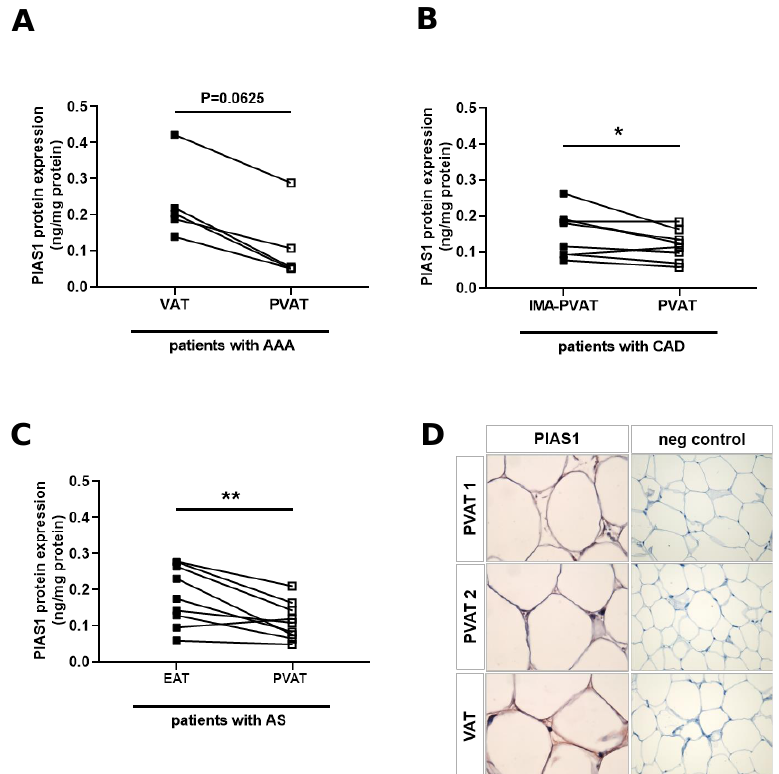
Figure 6. Expression of PIAS1 in human perivascular adipose tissue. Quantitative analysis of PIAS1 protein levels in visceral (VAT) and perivascular (PVAT) adipose tissue surrounding the aorta of patients ( n = 5) with abdominal aortic aneurysm (AAA) using an enzyme-linked immunoassay ( A ). Results are expressed per ng / mg total protein. Quantitative analysis of PIAS1 in PVAT surrounding the aortic root and coronary arteries of patients ( n = 8) with coronary artery disease (CAD) compared to PVAT surrounding the internal mammary artery (IMA-PVAT) ( B ). Quantitative analysis of PIAS1 in PVAT surrounding the aortic root and coronary arteries of patients ( n = 9) with aortic valve stenosis (AS) compared to epicardial adipose tissue (EAT) from the same patient ( C ). Exact p -values, as determined using the Wilcoxon matched-pairs signed rank test ( A ) or paired Student’s t -test ( B , C ) are shown within the graphs. Immunohistochemical detection of PIAS1 (red signal) in human VAT and PVAT ( × 400 magnification) ( D ). Results after the omission of the first antibody (neg control) are also shown ( × 200